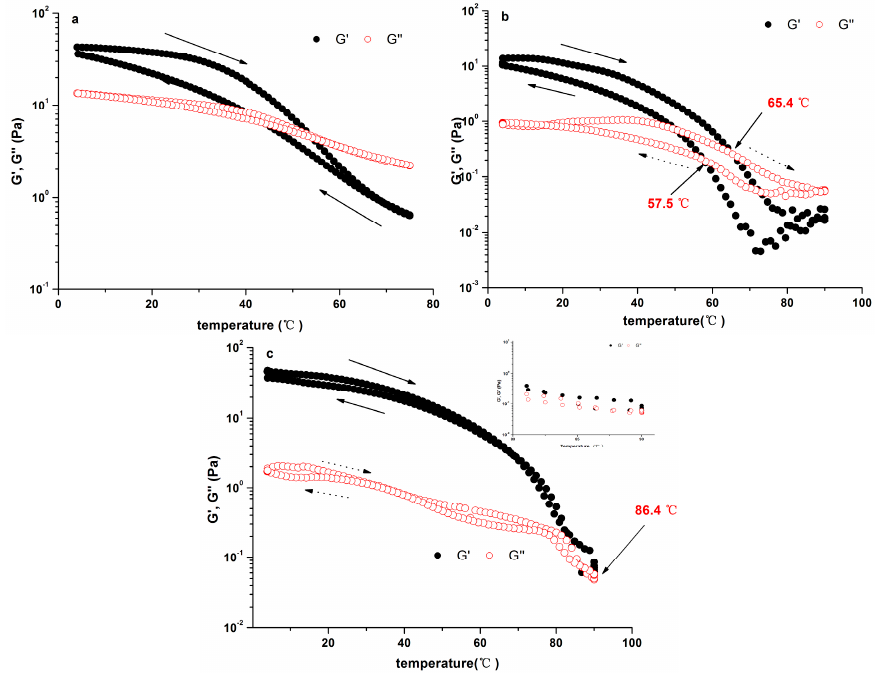
Figure 4. Variation in G ′ and G ″ of polysaccharide during heating and cooling by 2 °C/min. ( a ) without salt-3.0% PLAP; ( b ) with 0.2 M Na + -1.0% PLCP; ( c ): with 0.2 M Ca 2+ -1.0% PLCP.